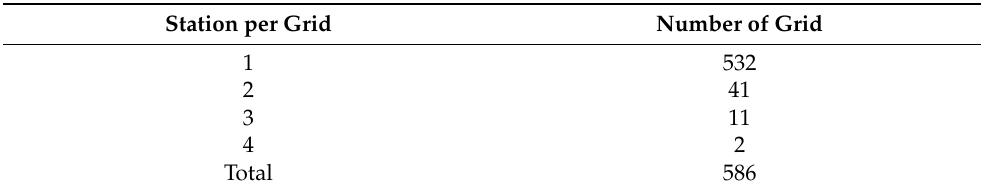
Table 2. The number of stations in the GSMaP